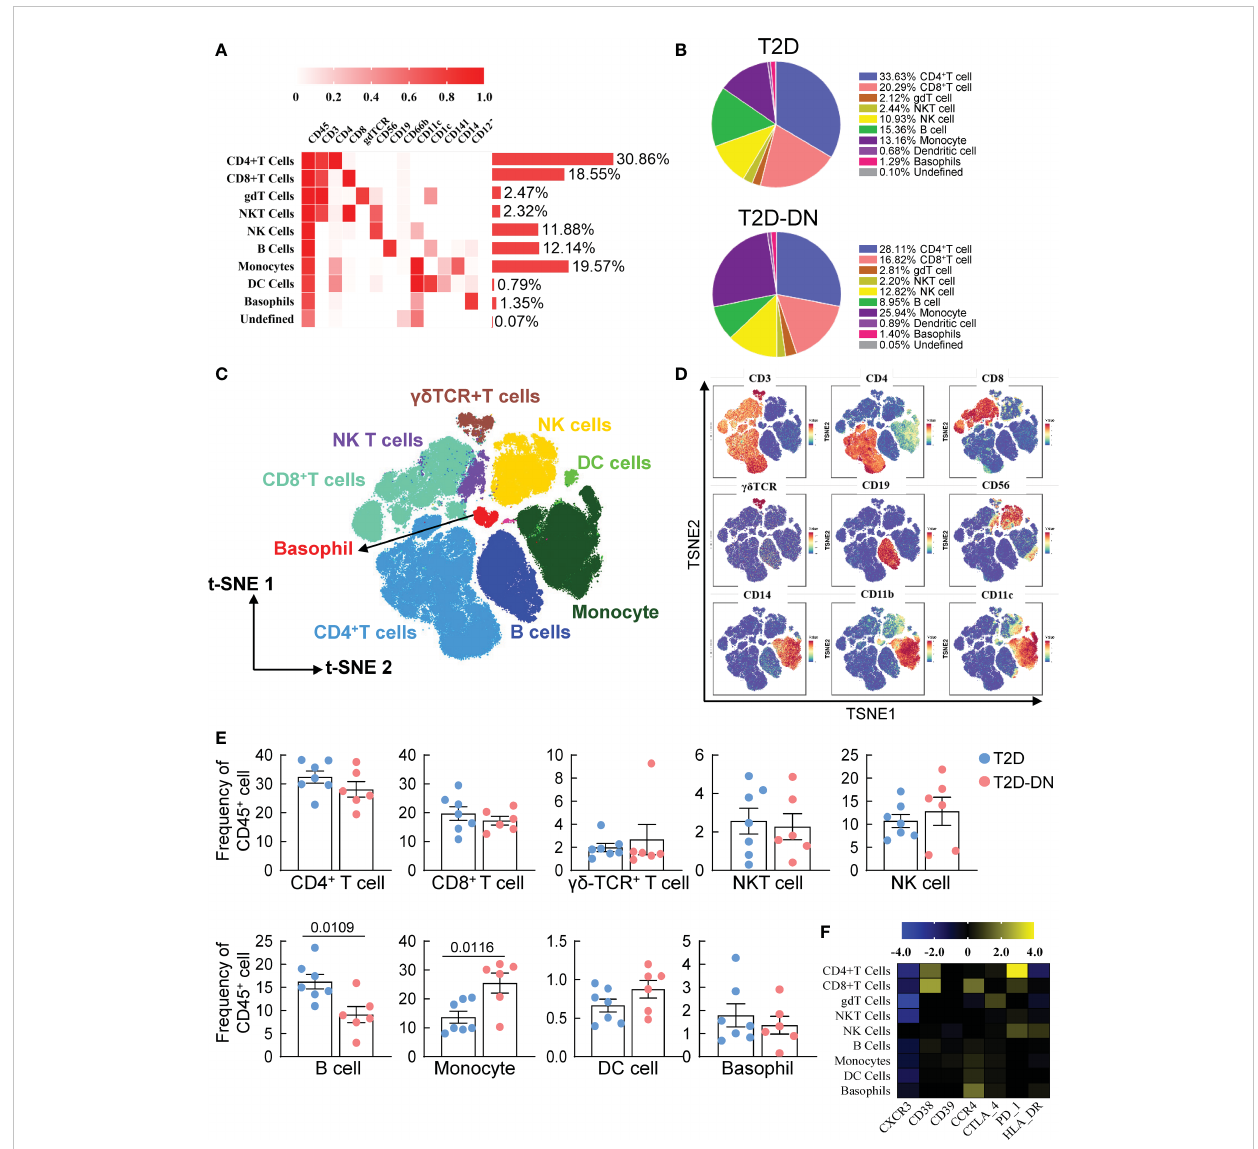
FIGURE 1 Peripheral immunity signature traits in the early-stage diabetic nephropathy patients. (A) Heatmap analysis for the overall proportions of major immune cell subsets in diabetic nephropathy (B) Pie chart characterizing the differences of major immune cell subsets proportions between T2D-DN and T2D patients. (C) Distributions of major immune cell subsets (D) The key immune cell markers for immune cell subsets are analyzed by t-SNE algorithm. (E) Statistical frequency differences of immune cell subsets between T2D-DN and T2D patients. (F) Heatmap analysis for the expressions of functional immune cell markers in the measurable immune cell subsets. Data are expressed as means ± SEM, n = 6 in T2D-DN group and n = 7 in T2D